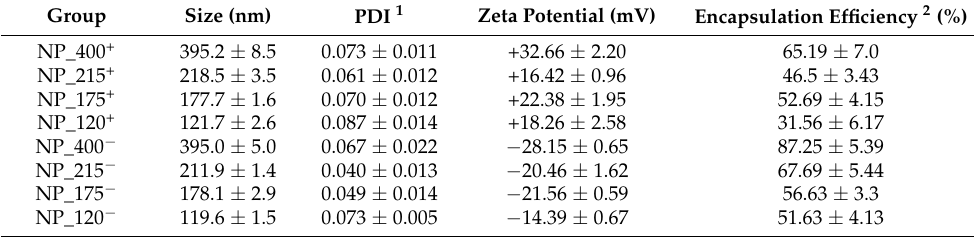
Figure 2. Nanoparticle characterization. Eight NP formulations were optimized to synthesize four statistically unique size groups of PLGA NPs (white bars) and equally-sized chitosan-containing controls (black bars). ( A ) Diameters (nm), ( B ) zeta potentials (mV), and ( C ) polydispersity indices (PDI) of the eight NP formulations. ( D ) TEM images of the eight NP formulations. Scale bar: 200 nm. For all datasets, values are means ± SD, n = 4 separately prepared lots. * p < 0.001 vs -Chitosan counterpart. Table 2. Summary of Nanoparticle Characteristics.